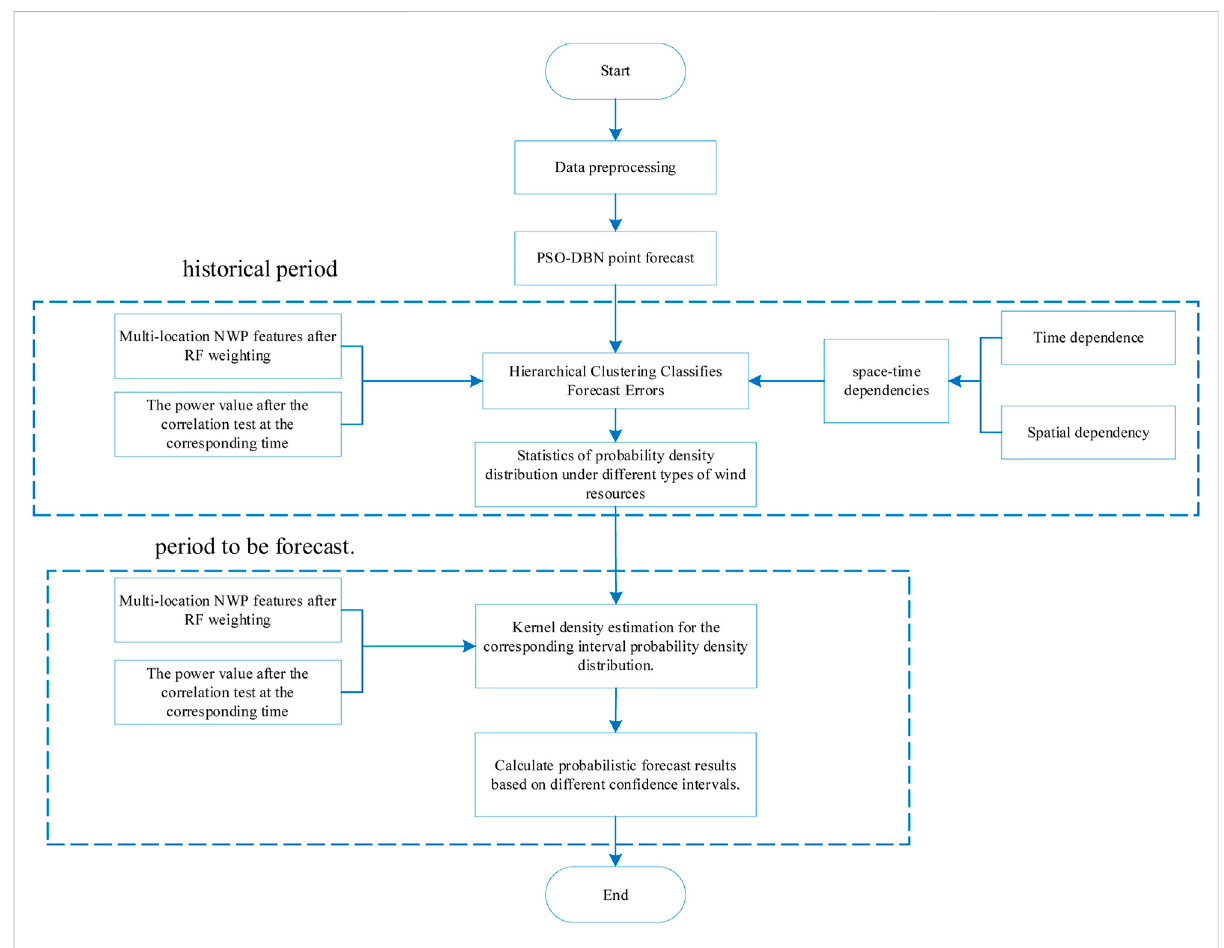
FIGURE 7 Flow chart of short-term prediction of wind power based on kernel density